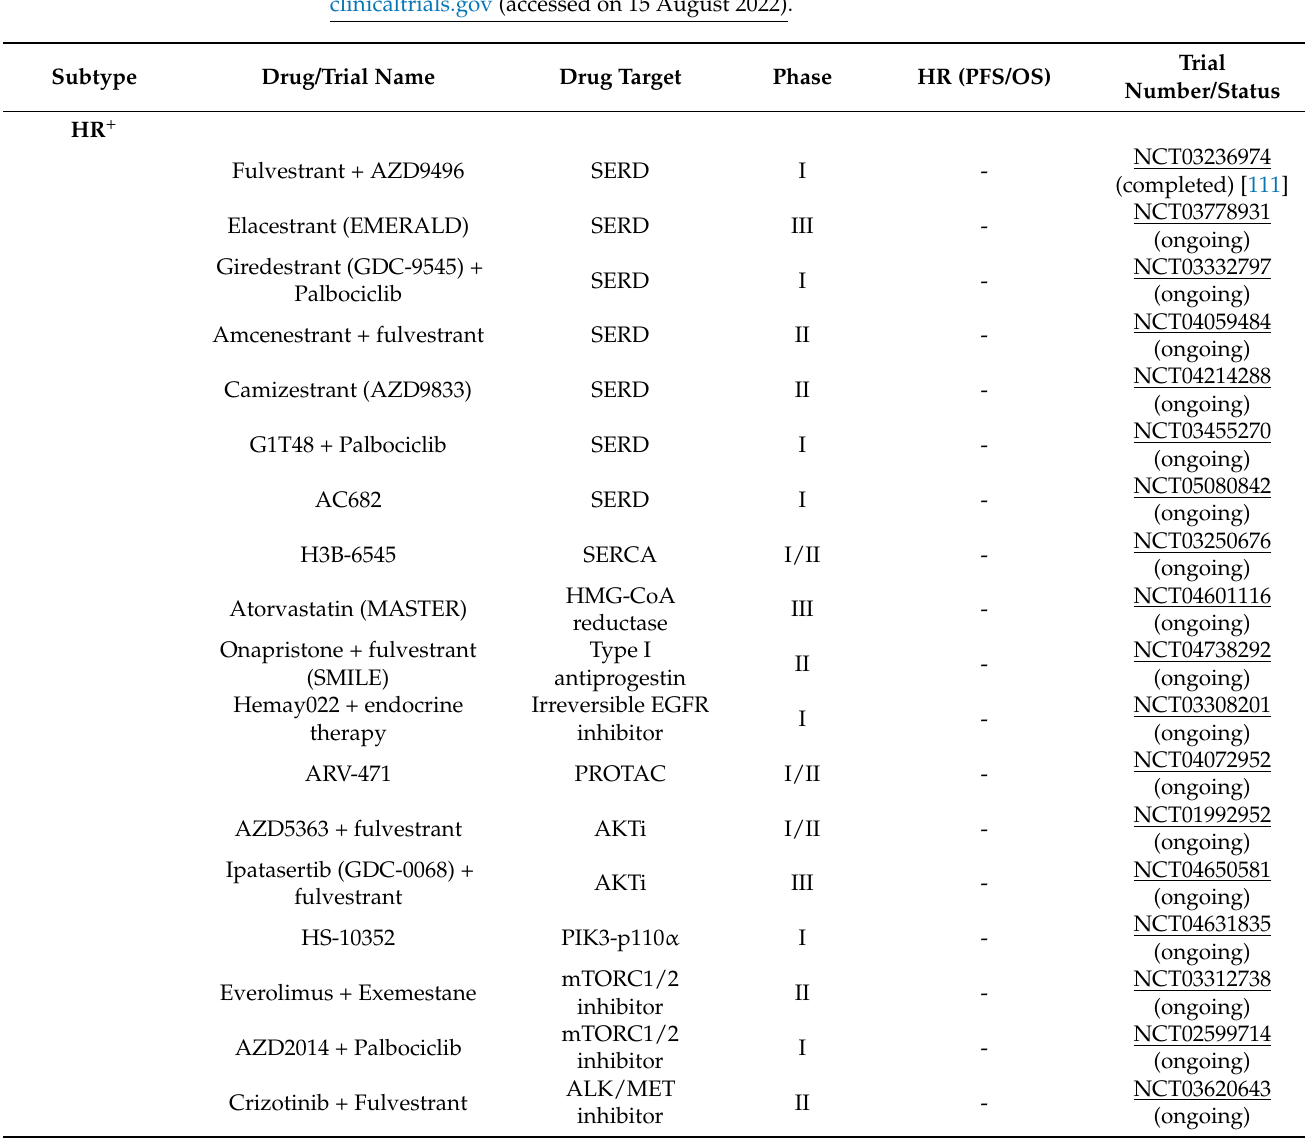
3. Summary of ongoing clinical trials for mBC derived